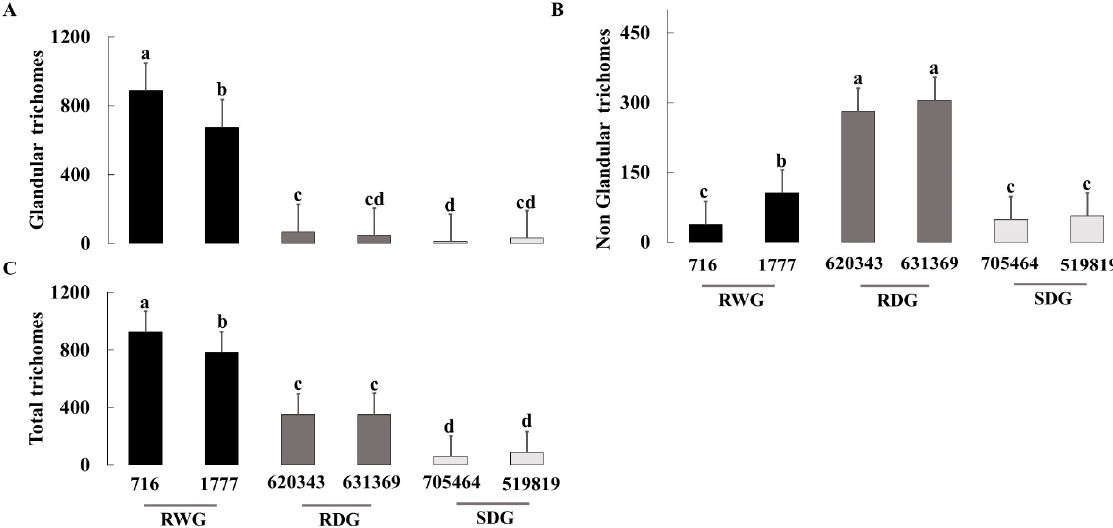
Figure 6. Mean density (number per 1 cm 2 ± SE) of glandular ( A ), non-glandular ( B ), and total ( C ) trichomes on leaves of six tomato genotypes with different levels of resistance to Phthorimaea absoluta . Bars with shared letters within the panel do not differ significantly (one-way ANOVA; Tukey test; p ≤ 0.05). RWG = resistant wild genotypes; RDG = resistant domesticated genotypes; and SDG = susceptible domesticated genotypes.